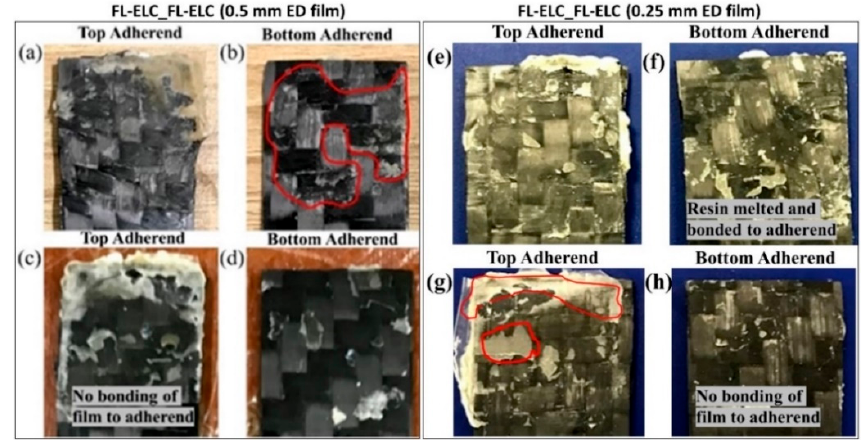
Figure 20. Fracture images of the top and bottom adherends for maximum LSS (a–b) and minimum LSS ( c–d ) FL-ELC_FL-ELC (0.5 mm ED film) and maximum LSS (e–f) and minimum LSS (g–h) for FL-ELC_FL-ELC (0.25 mm ED film).